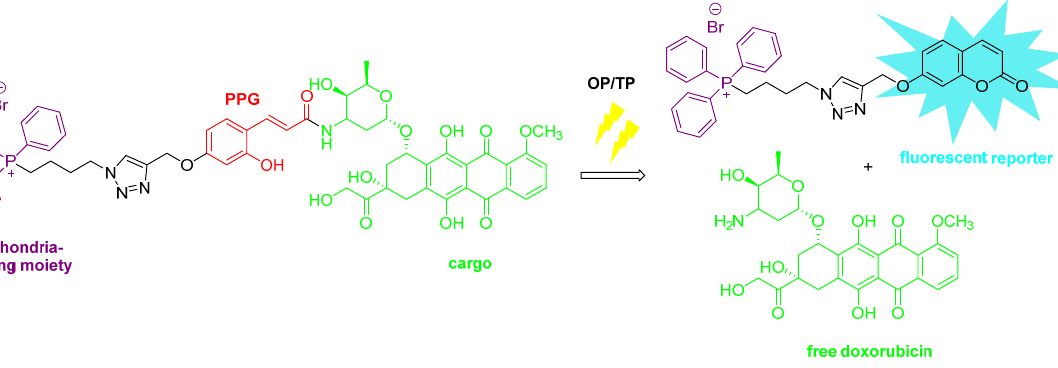
Figure 8. Mitochondria-targeted light-activatable drug delivery system offering real-time fluorescent monitoring of the release process [58].